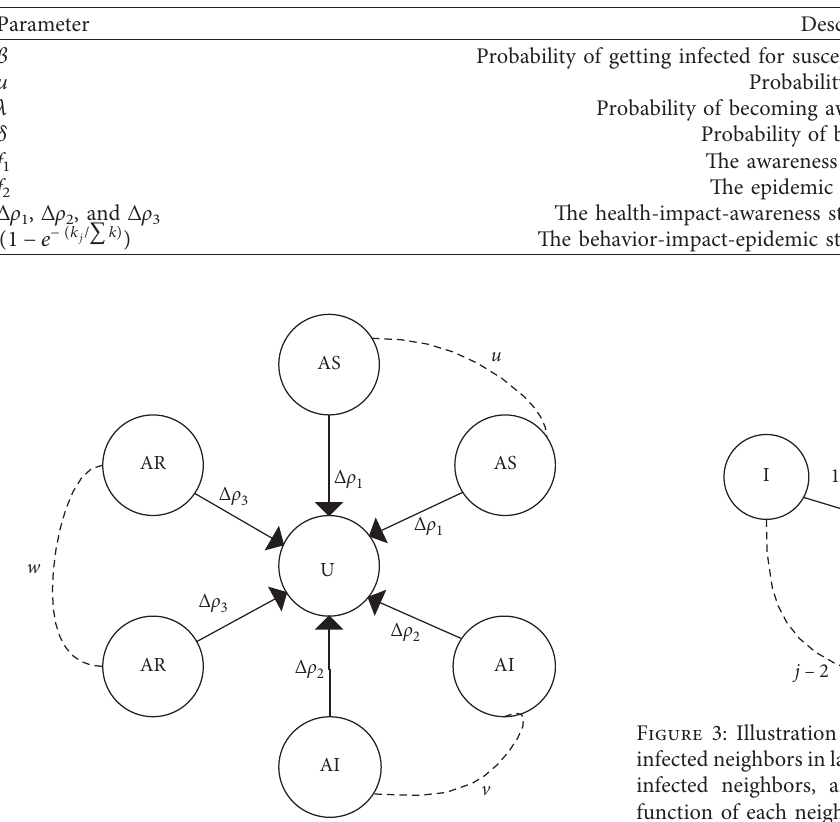
Figure 2: Explanation of the health-impact-awareness status of aware neighbors in layer 1. The numbers of AS, AI, and AR are u , v , and w , respectively. Also, the health-impact-awareness factors of the three aware neighbors are ∆ ρ 1 , ∆ ρ 2 , and ∆ ρ 3 , respectively.